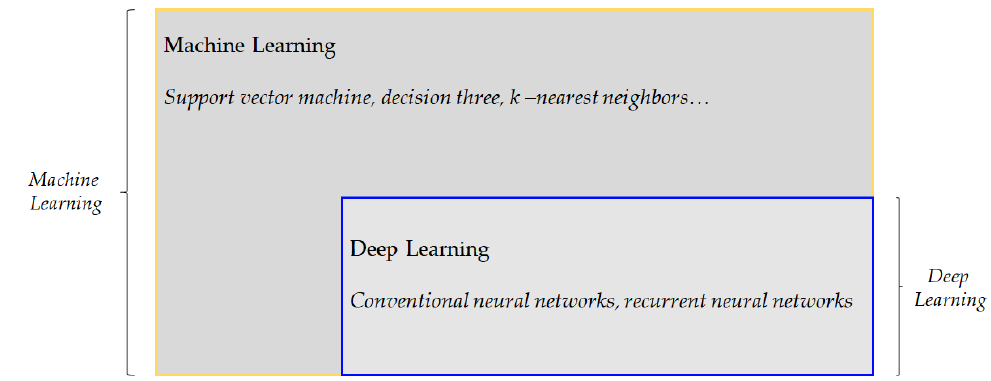
Figure 2. Machine learning vs. deep learning algorithms.